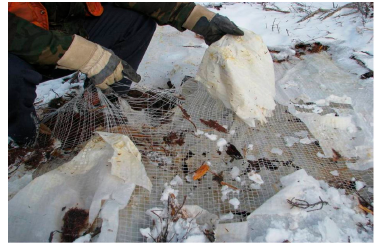
Figure 6. Paper-based tarp after six months.